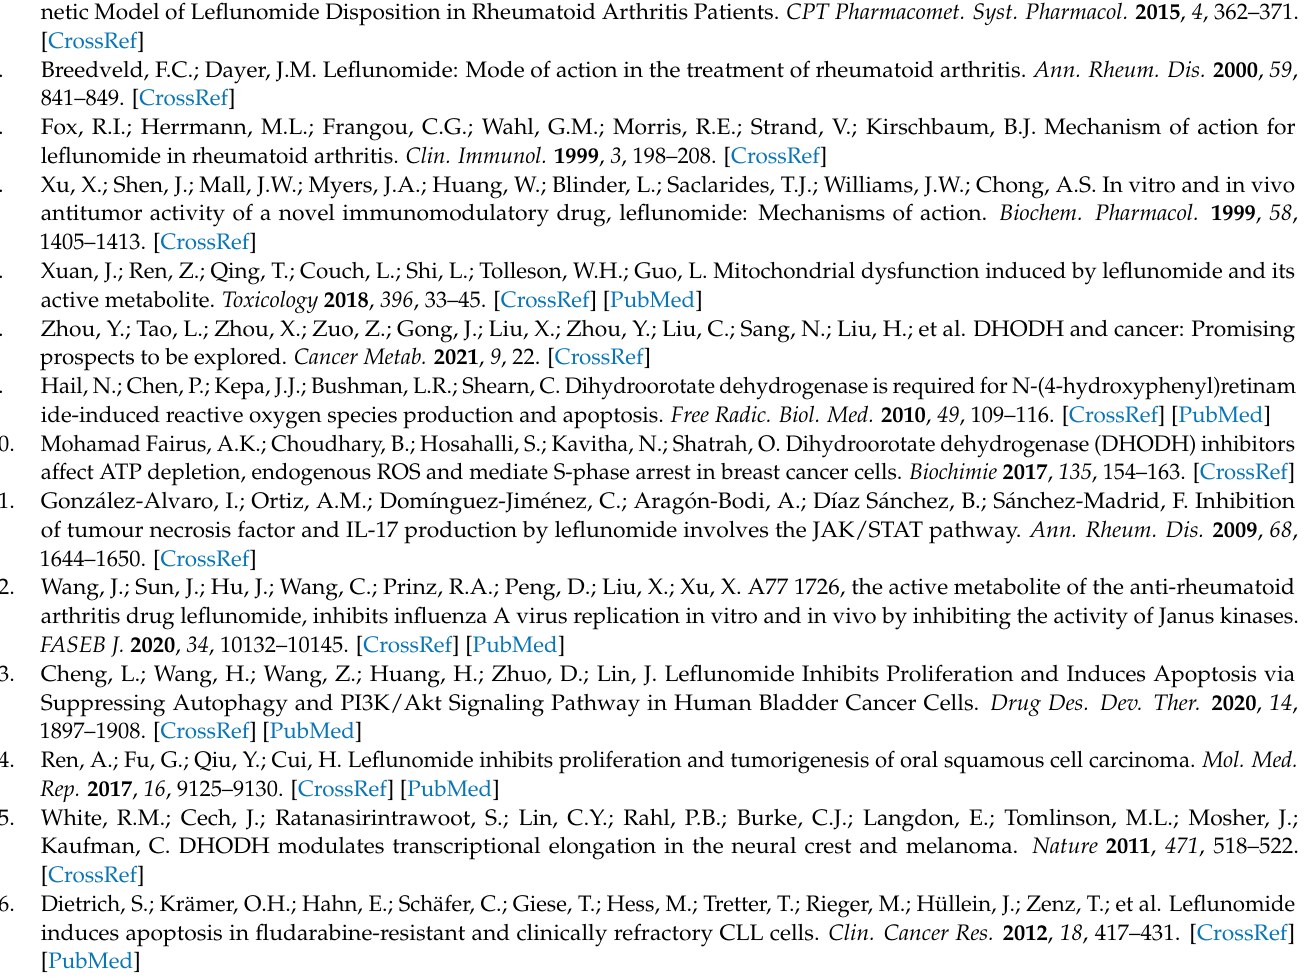
Figure S3. A Chromatogram of nuclear fraction (control without A771726), B chromatogram of nuclear fraction from cells culture incubated with A771726. Figure S4. A Chromatogram of mitochondrial fraction (control A771726), B chromatogram of mitochondrial fraction from cells culture incubated with